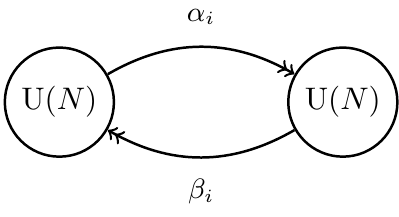
Figure 1 . Quiver gauge theory of N D3-branes probing the conifold C